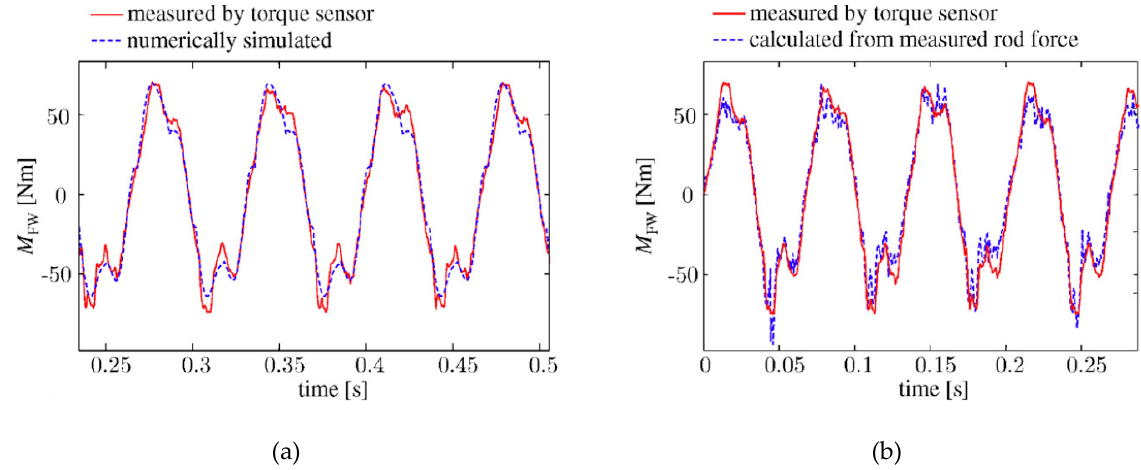
Figure 11. ( a ) Numerically simulated non-uniform part of the engine torque Δ𝑀 (cid:3006)(cid:3041)(cid:3034) (𝜑) and compensation torque 𝑀 (cid:3007)(cid:3024) (𝜑) of the synthesized KDF. ( b ) Flywheel angular speed 𝜑(cid:4662) (cid:3036)(cid:3031)(cid:3032)(cid:3028)(cid:3039) for complete compensation of Δ𝑀 (cid:3006)(cid:3041)(cid:3034) (𝜑) and flywheel angular velocity 𝜓(cid:4662)(𝜑) of the synthesized KDF [27]. Figures are reprinted with